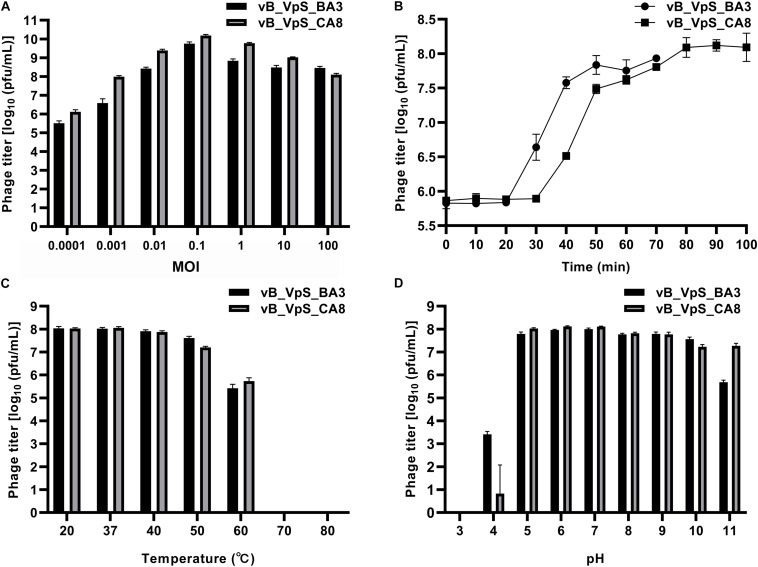
Biological characterization of vB_VpS_BA3 and vB_VpS_CA8. (A) Multiplicity of infection; (B) Kinetics of progeny production in the single life cycle; (C) Thermal stability of two phages treated with different temperature for 1 h; (D) pH stability of two phages treated with different pH for 1 h. Results are presented as mean values ± SD and shown as log10 (pfu/mL).